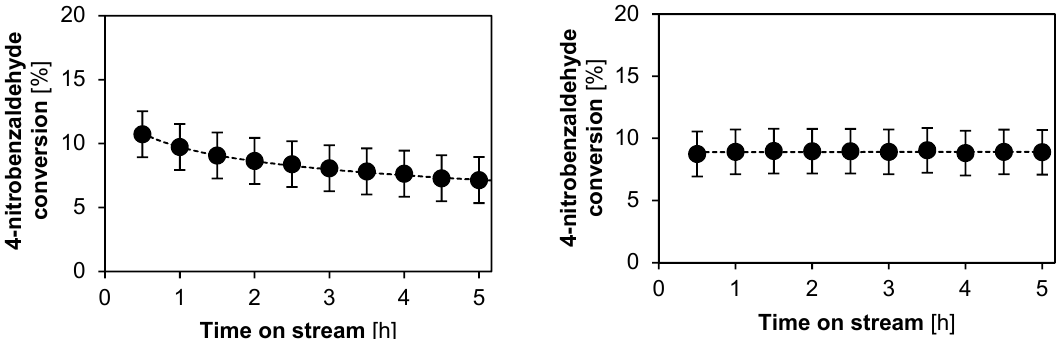
Figure 7. Conversion as a function of time on stream for the aldol reaction between acetone and 4-nitrobenzaldehyde, catalyzed by the monofunctional base catalyst, using DMSO as a solvent with varying amounts of water. Left: no added water, Right: 2 wt % water added. (T = 55 °C, P tot = 180 kPa, site time = 165.1 mol site s mol − 1 , 0.45 wt % 4-nitrobenzaldehyde, 44.6 wt % acetone, 52.5–55.0 wt % DMSO, 0.25 wt % IS). Fixed error of 1.8%. Line is a guide for the eye.